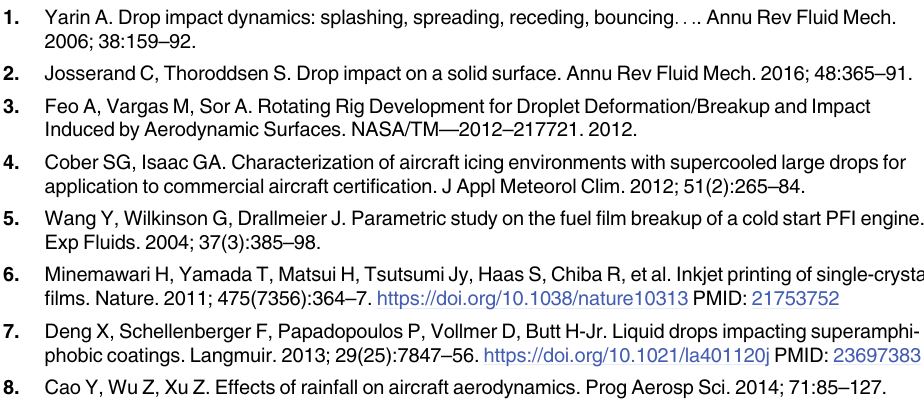
S2 Fig. Interface calculation approach adopted in Fluent VOF model. S3 Fig. Mesh topology in the present study. S4 Fig. Mesh independence examination